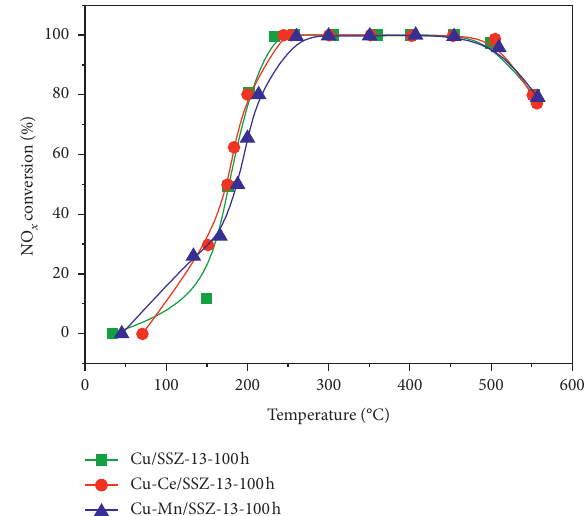
Figure 9: NO x conversion after aging treatment for 100h using NH 3 for addition of Ce or Mn on Cu/SSZ-13